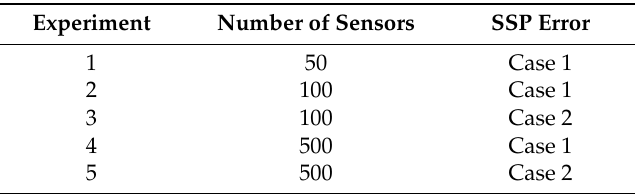
Table 2. Experimental